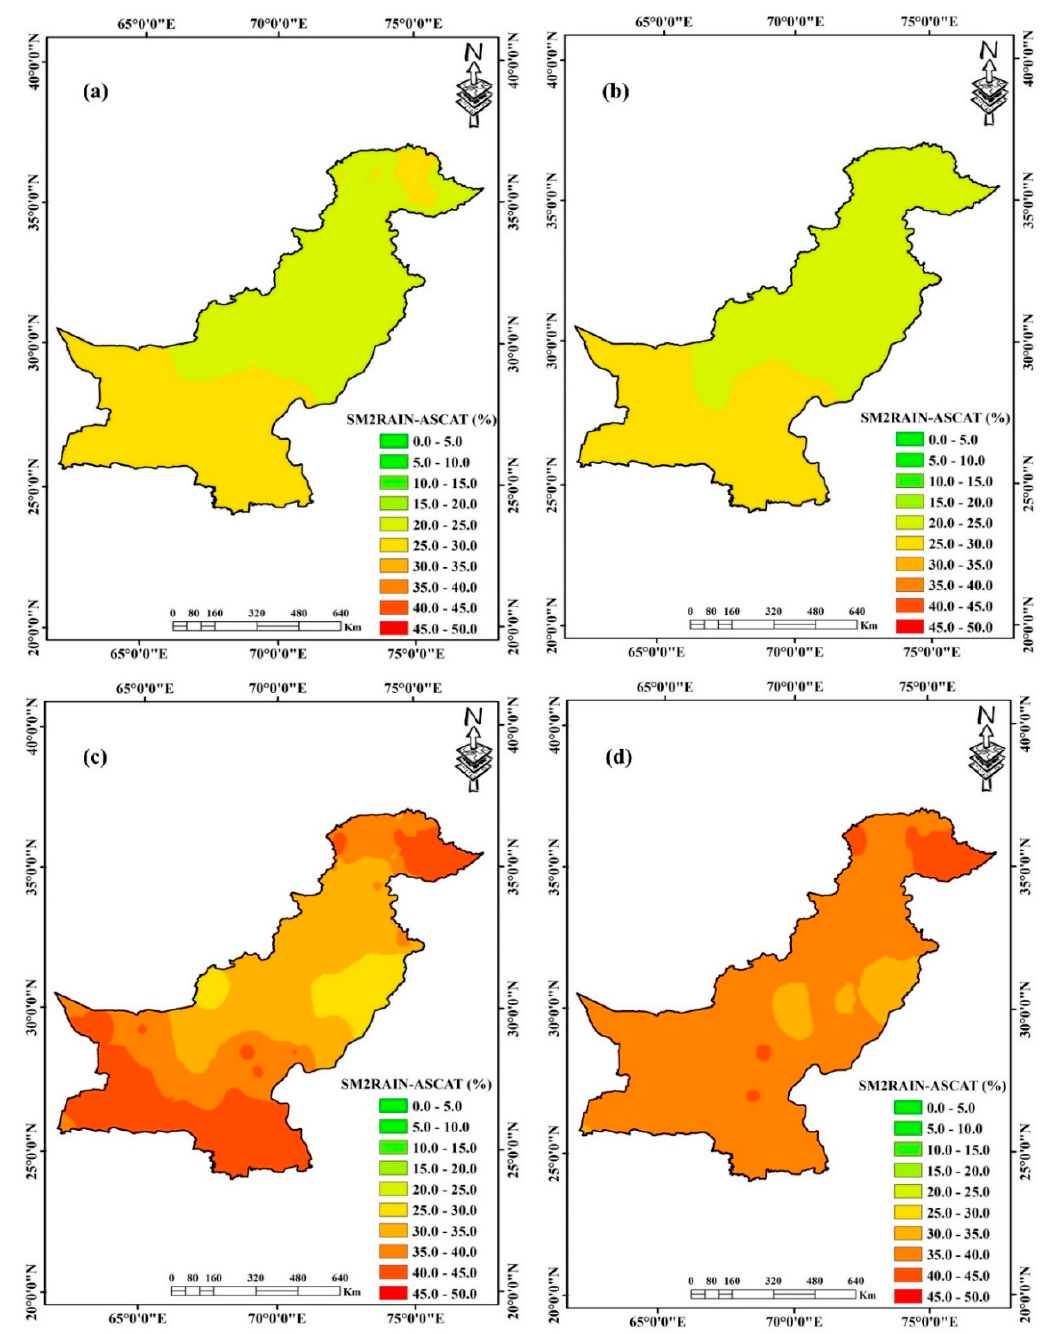
Figure 6. Spatial distribution of average SM2RAIN-ASCAT seasonal weights across Pakistan from 2007 to 2018. ( a ) Pre-monsoon; ( b ) Monsoon; ( c ) Post-monsoon; ( d ) Winter.